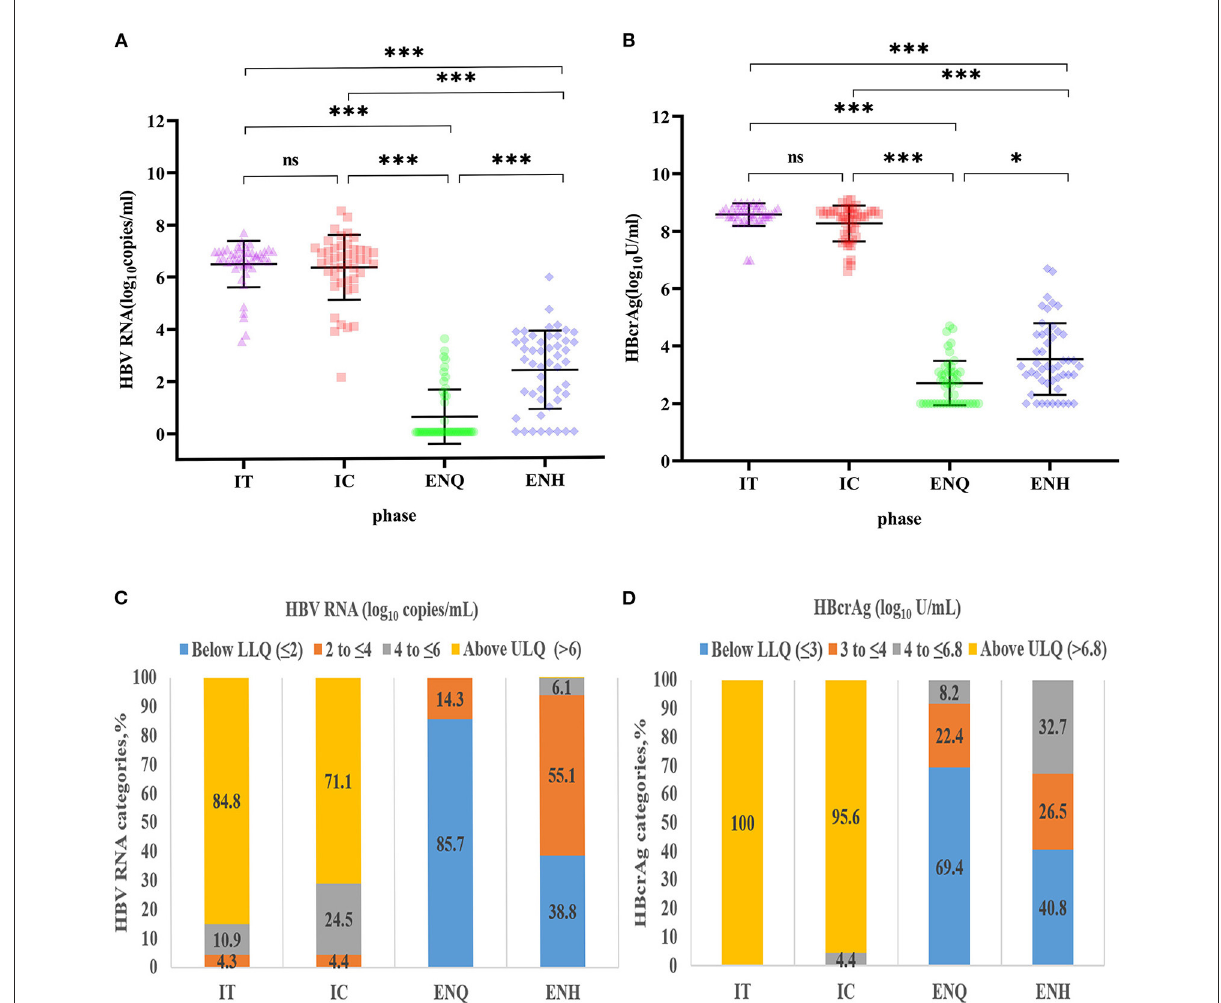
FIGURE1 Distribution of HBV RNA and HBcrAg concentrations during the natural course of CHB infection. (A) HBV RNA concentration distribution during the natural course of CHB infection. *** p < 0.001; * p < 0.05; ns, no statistical significance. (B) HBcrAg concentration distribution during the natural course of CHB infection. *** p < 0.001; * p < 0.05; ns, no statistical significance. (C) HBV RNA (log 10 copies/mL) category distribution during the natural course of CHB infection. (D) HBcrAg (log 10 IU/mL) category distribution during the natural course of CHB infection. IT, immune tolerance; IC, immune clearance; ENQ, hepatitis B e antigen-negative inactive/quiescent carrier phase; ENH, hepatitis B e antigen-negative hepatitis; HBV, hepatitis B virus; HBcrAg, hepatitis B core-related antigen; CHB, chronic hepatitis